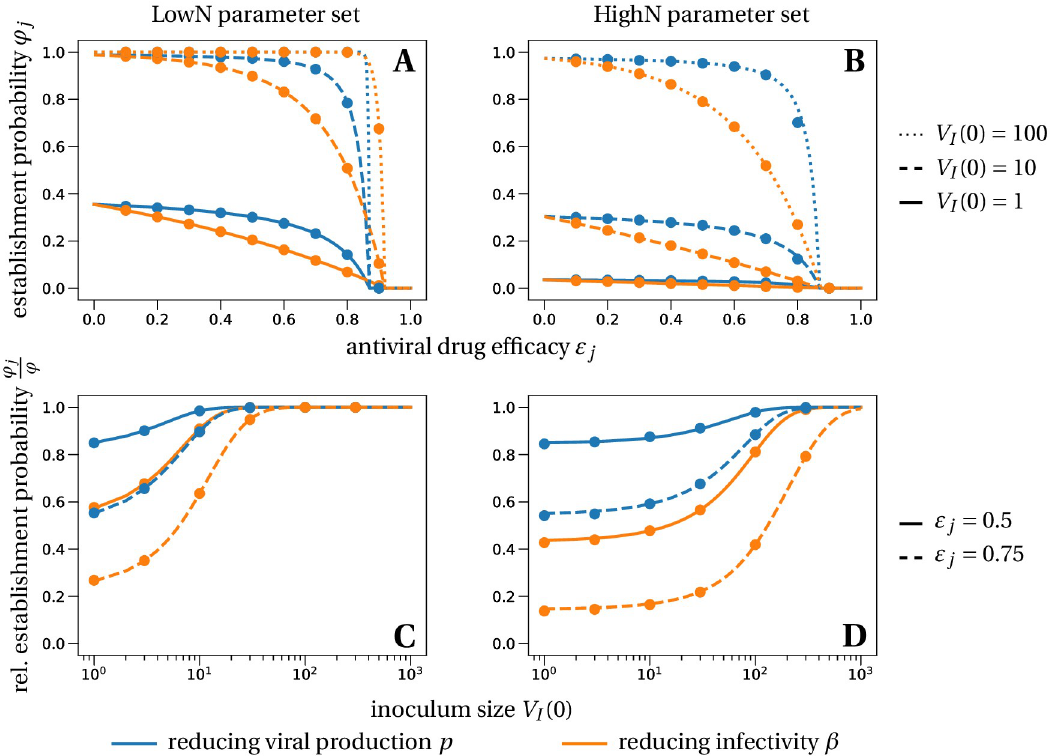
Fig 2. Establishment probability of a viral infection under prophylactic treatment with different antiviral drugs, efficacies ε and various inoculum sizes V 0 . The lines in panels A and B correspond to the theoretical establishment probability under the assumption that target cell numbers are constant, for the two modes of action (reducing viral infectivity equivalent to increasing clearance, Eq (5), in orange and reducing viral production equivalent to increasing cell death, Eq (6), in blue). The lines in the bottom panels represent the relative probability of establishment normalized by the establishment probability in the absence of treatment from Eq (4), i.e. φ j / φ . Dots are averages from 100, 000 individual-based simulations of the within-host model described in system (3), in which target cell numbers are allowed to vary. Parameter values are given in Table